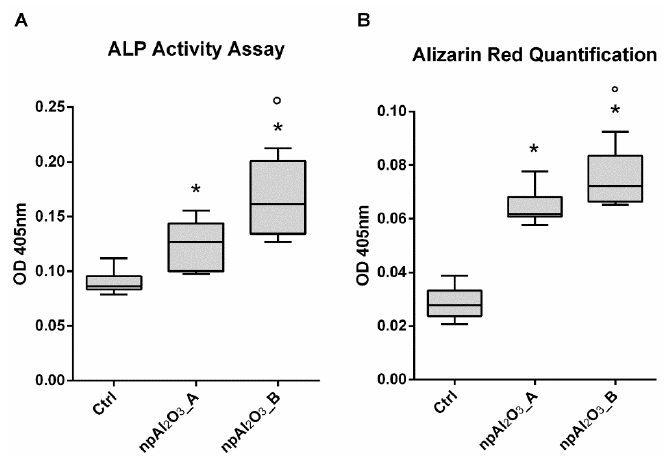
Figure 7. Osteogenic evaluation. Alkaline Phosphatase (ALP) activity assay ( A ) and Alizarin Red S quantification ( B ) performed by seeding MC3T3-E1 on different samples for 7 days ( A ) and for 21 days ( B ). The symbol (*) indicates a statistically significant difference versus the control (Ctrl), considering a p -value < 0.05. The symbol (°) indicates a statistically significant difference versus npAl 2 O 3 _A, considering a p -value < 0.05.